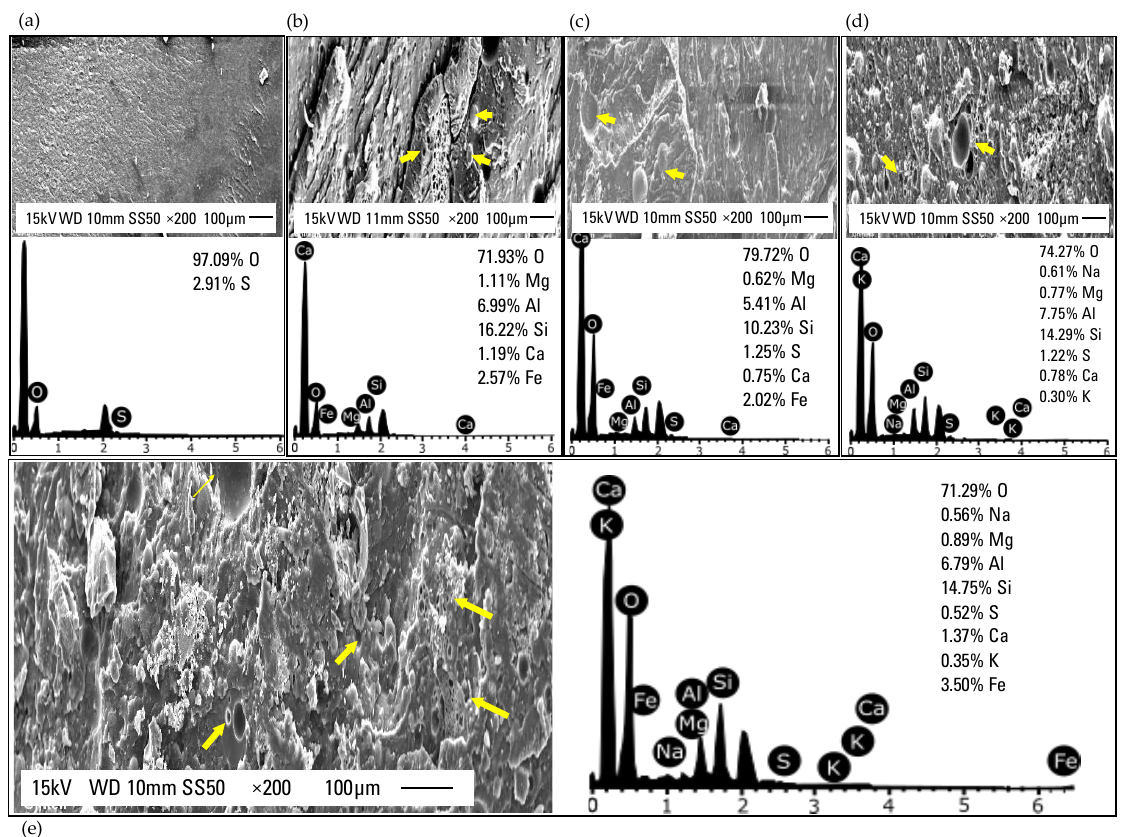
Figure 2. SEM and EDX analysis for ( a ) RP, ( b ) RPF1, ( c ) RPF2, ( d ) RPF3, ( e ) RPF4. The yellow arrows show the particle agglomerates and voids.